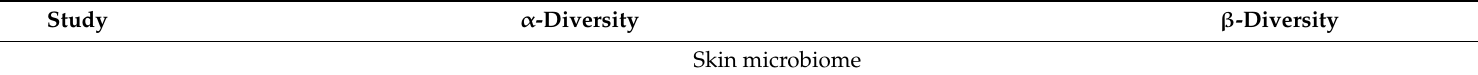
Table 3. α - and β -diversity of microbiota in